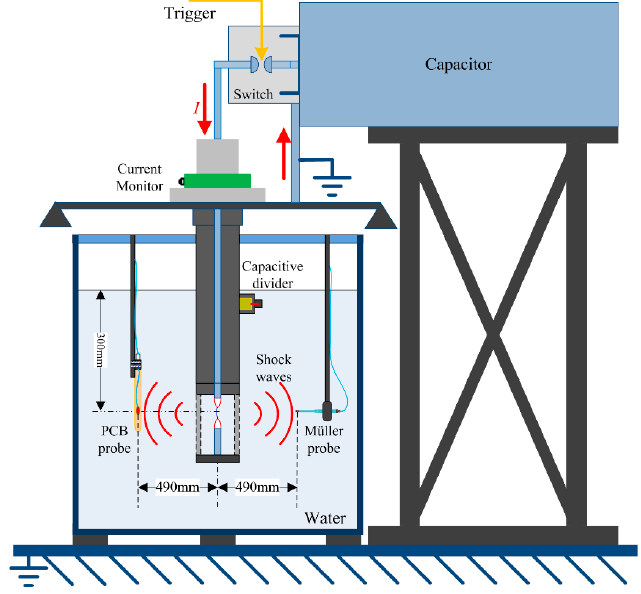
Figure 1. Schematic diagram of the SW generator based on UEWE.